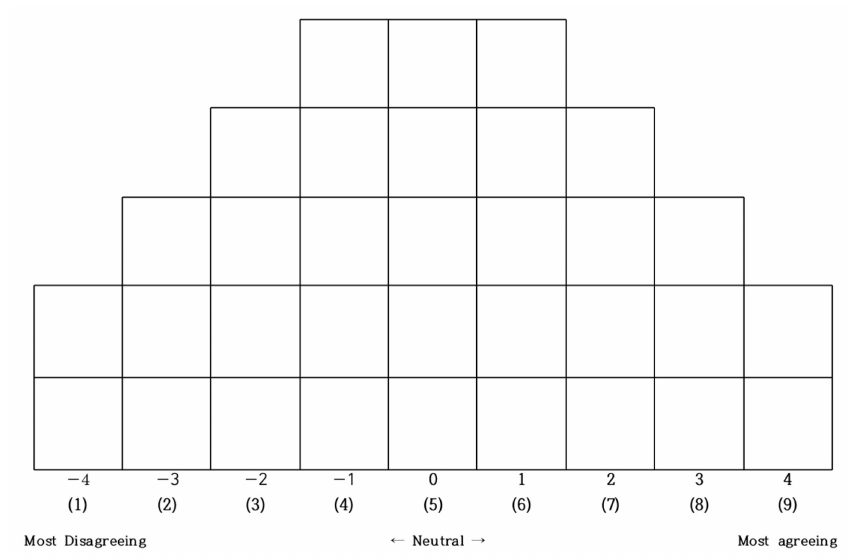
Figure 2. A diagram of Q-sample sorting.